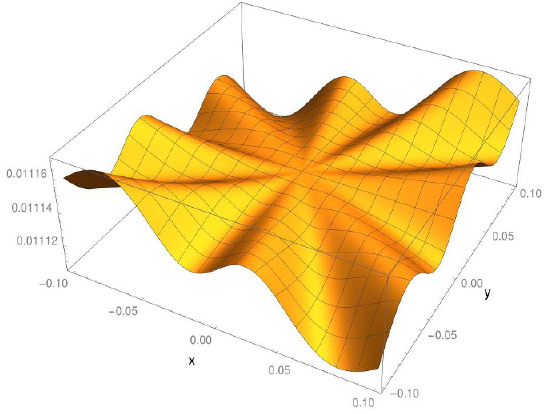
Figure 3 . The scalar potential generated by a generic choice of flux, depending on the distance to the orbifold O 1 in coordinates o 1 = x + Iy, o 2 =